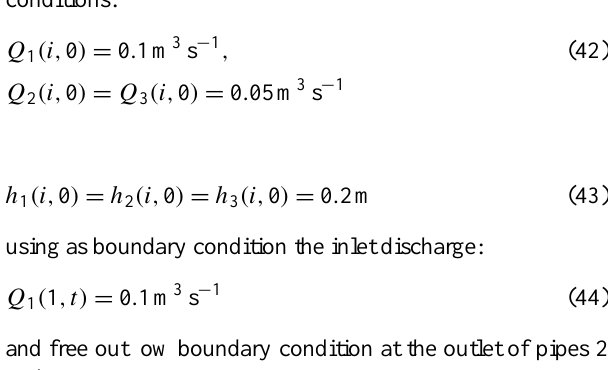
Figure 13. (Scheme of the looped pipe network. Fig. 3. Manning roughness coefficient for all the pipes is Drink. Water Eng. Sci. 0.01 s m − 1 / 3 . The main branch has a slope of 0.002 and the secondary ones Drink. Water Eng. Sci.